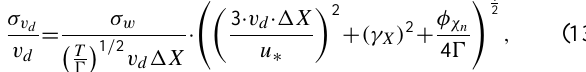
2.3 × 10 − 2 ppbv 2 Hz − 1 or 3.7 × 10 − 17 mol 2 m − 6 Hz − 1 .